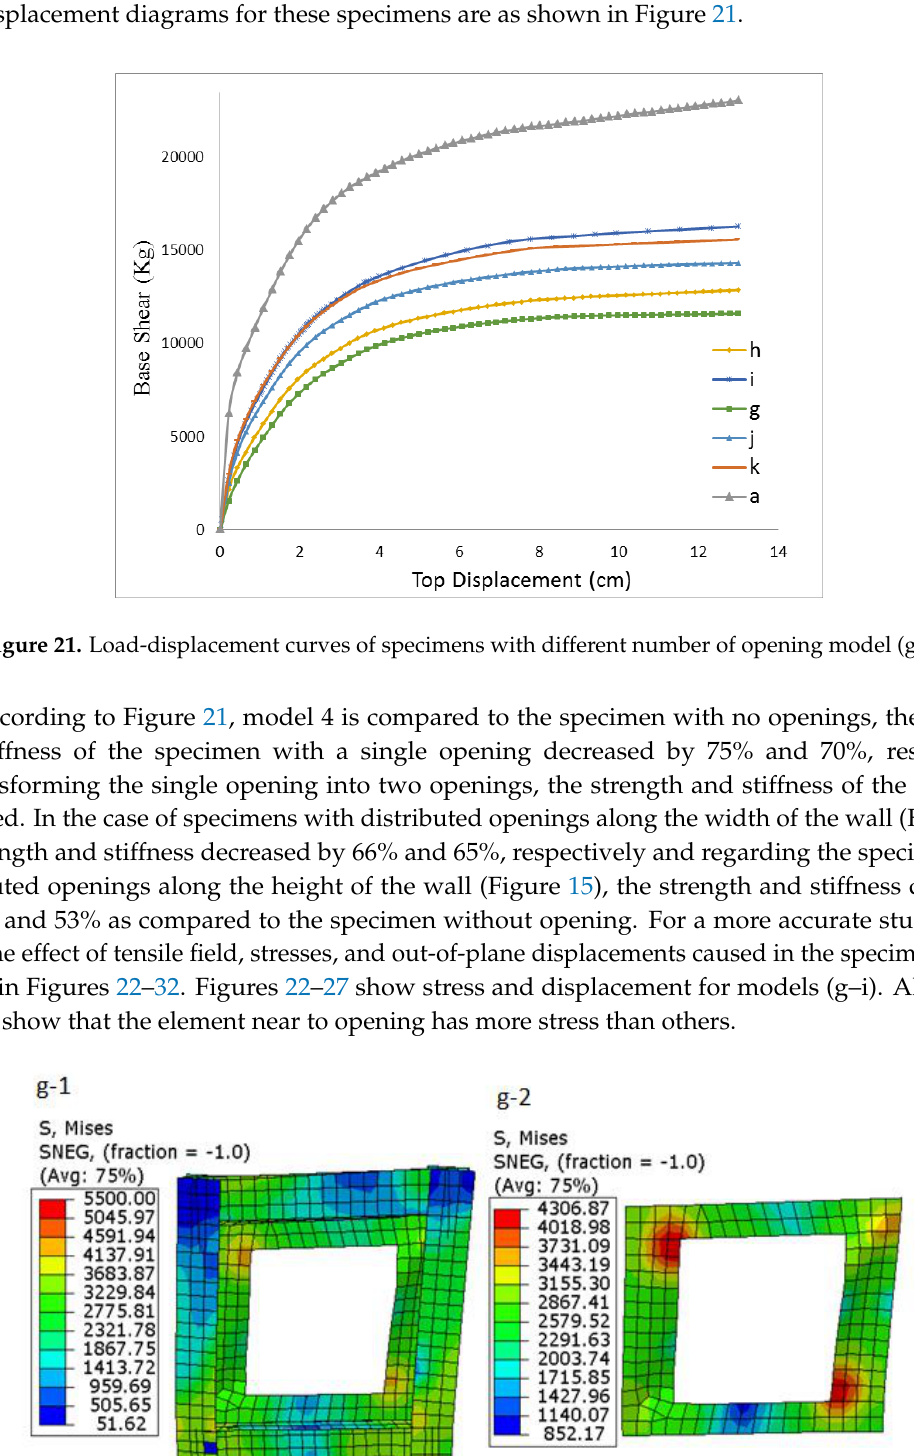
Figure 22. Figure 18 Von Mises stress for shell part (g-1) frame part and (g-2) steel plate.